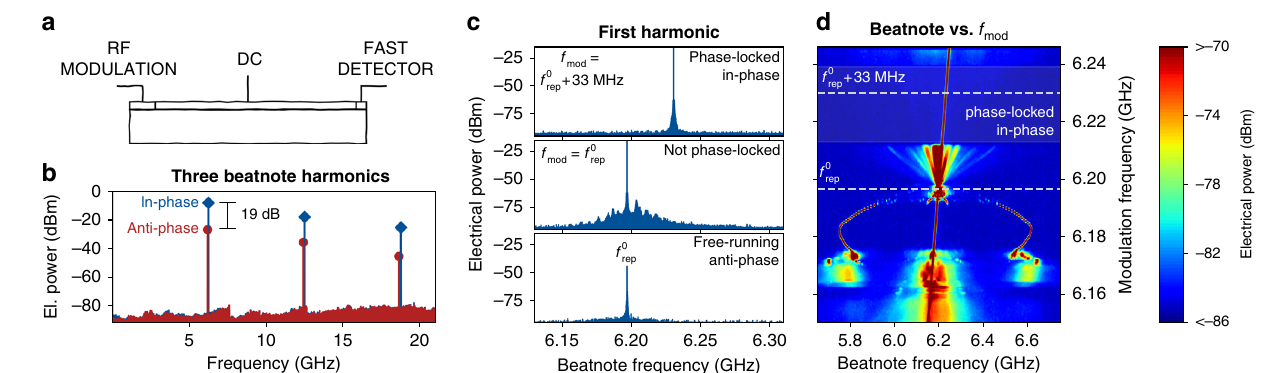
Fig. 3 Synchronization under strong modulation. a Schematic of a 3-section QCL comprised of modulation, gain and high-speed detector sections. b First three harmonics of the beatnote of the free-running 7 mm long QCL FM comb (red) compared to the actively mode-locked QCL (AM comb, blue) in logarithmic scale. c Laser beatnote while free-running (bottom), at f mod ¼ f 0 for f mod ¼ f 0 , the beatnote is perfectly locked for f mod ¼ f 0 rep around f 0 . The phase-noise of the RF spectrum disappears abruptly at f mod (cid:2) f 0 rep beatnote consists of a single narrow peak, indicating that the laser is phase-locked to the modulation. Furthermore, the sharp sidepeaks visible at f ¼ 6 : 18 GHz are attributed to a periodic modulation of the QCL output, as previously observed in simulations mod